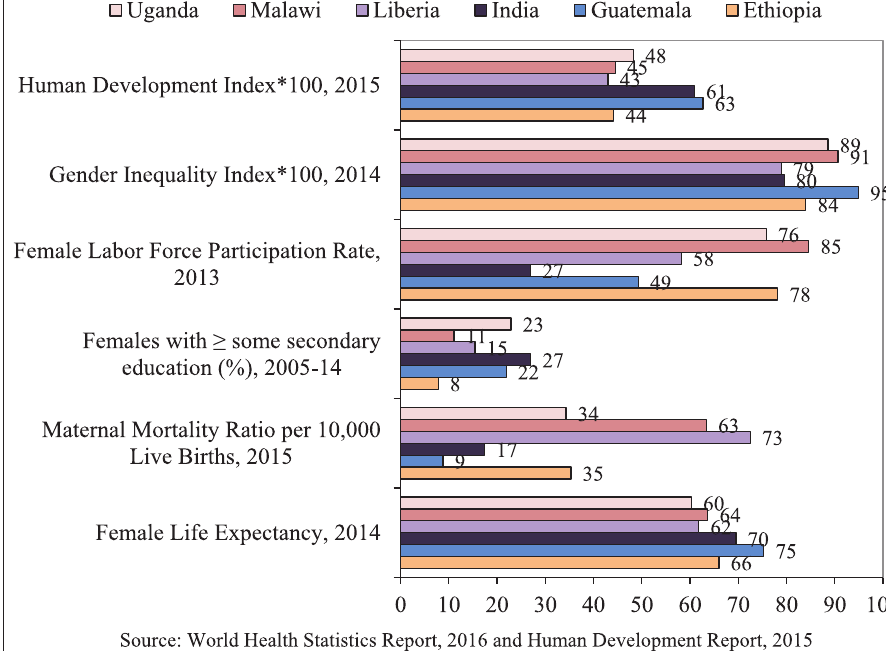
Figure 1: Women’s Health and Social Status: A Comparison of Six Developing